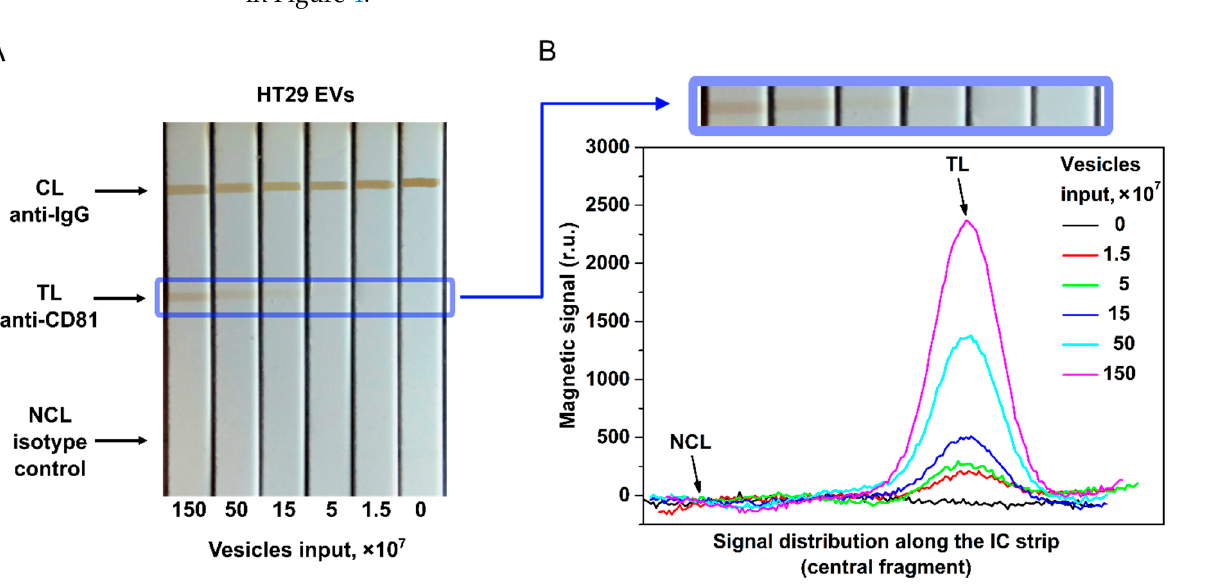
Figure 4. EV quantification by the developed nanomagnetic IC tool. ( A ) Photograph of the IC strips for HT29 EVs with anti-CD81 as capture antibody and anti-CD9 as tracer antibody. ( B ) Signal distribution along the IC strip at different EV inputs (data for CD81 + /CD9 + HT29 EVs).